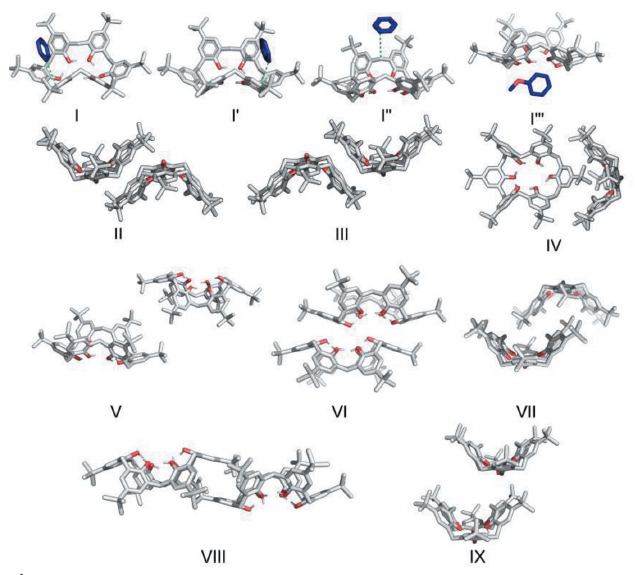
Figure 4 Selected dimer motifs extracted from the guest–TBC6 crystal